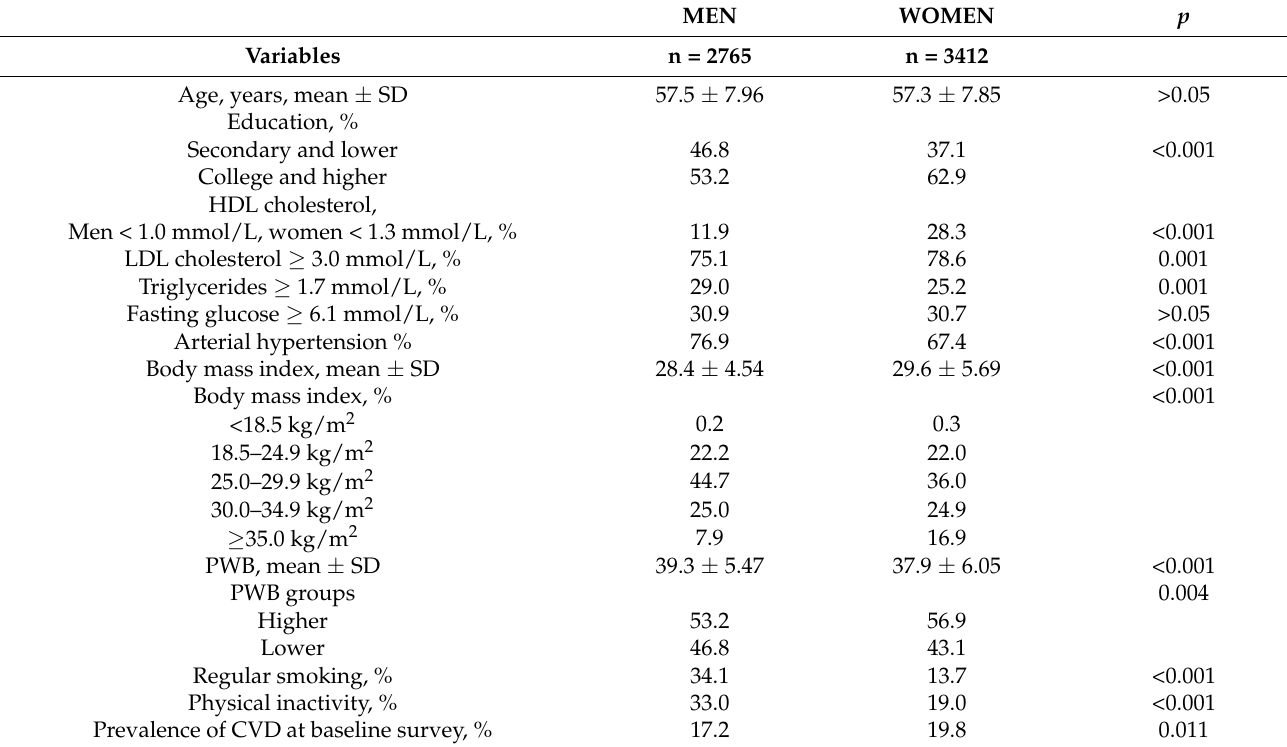
Table 1. Baseline characteristics of men and women of the Kaunas HAPIEE study (2006–2008).